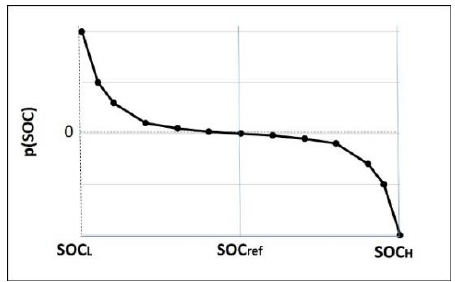
Figure 6. An example of state of charge ( SOC ) penalty weight used in ECMS [39].